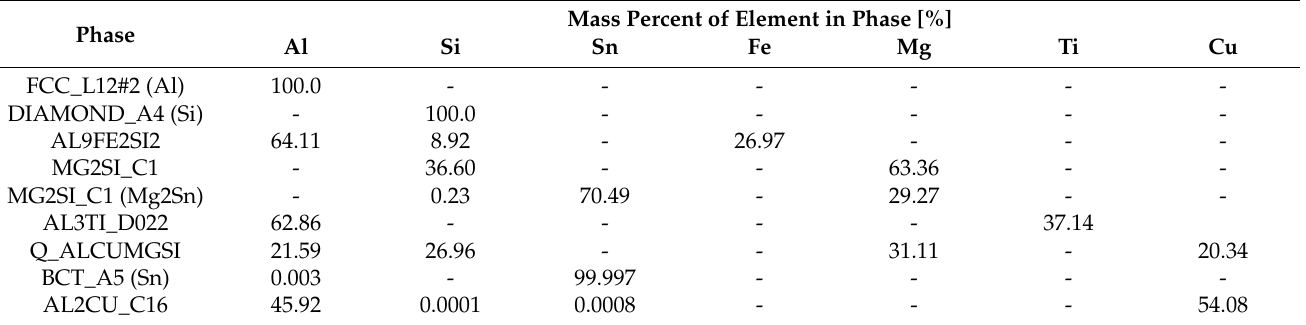
Table 4. Content of individual elements in phases that occurred during crystallisation of examined AlSiSn alloys.